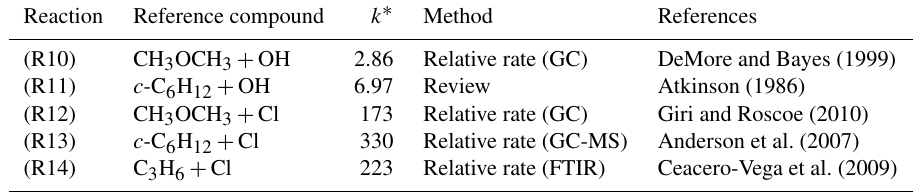
Table 1. Literature kinetic data for reference compounds used in determinations of k 1 (296K) and k 2 (296K).